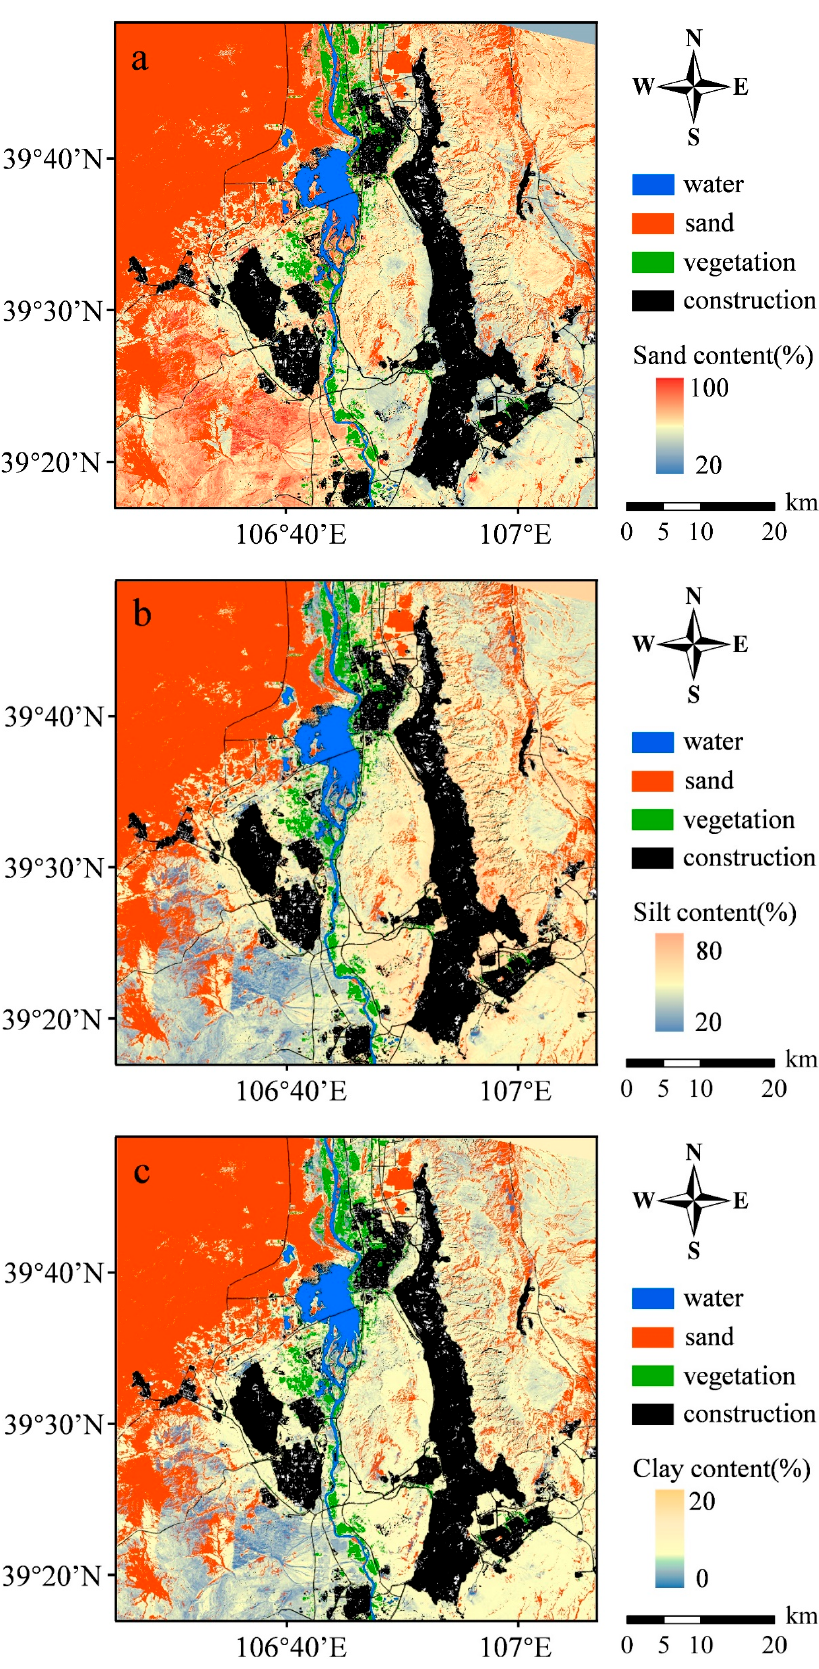
Figure 14. Inversion results of soil particle sizes’ contents ( a ) sand, ( b ) silt, and ( c ) clay.